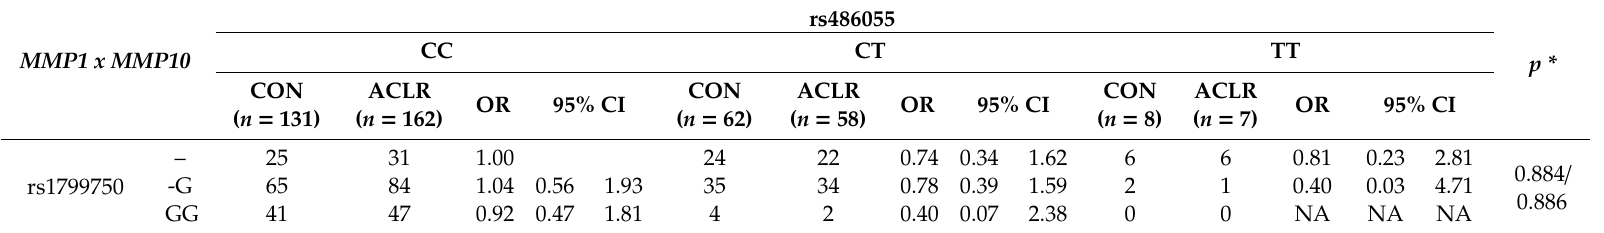
Table 3. Association analysis of the MMP1 x MMP10 interaction with non-contact ACL rupture (codominant